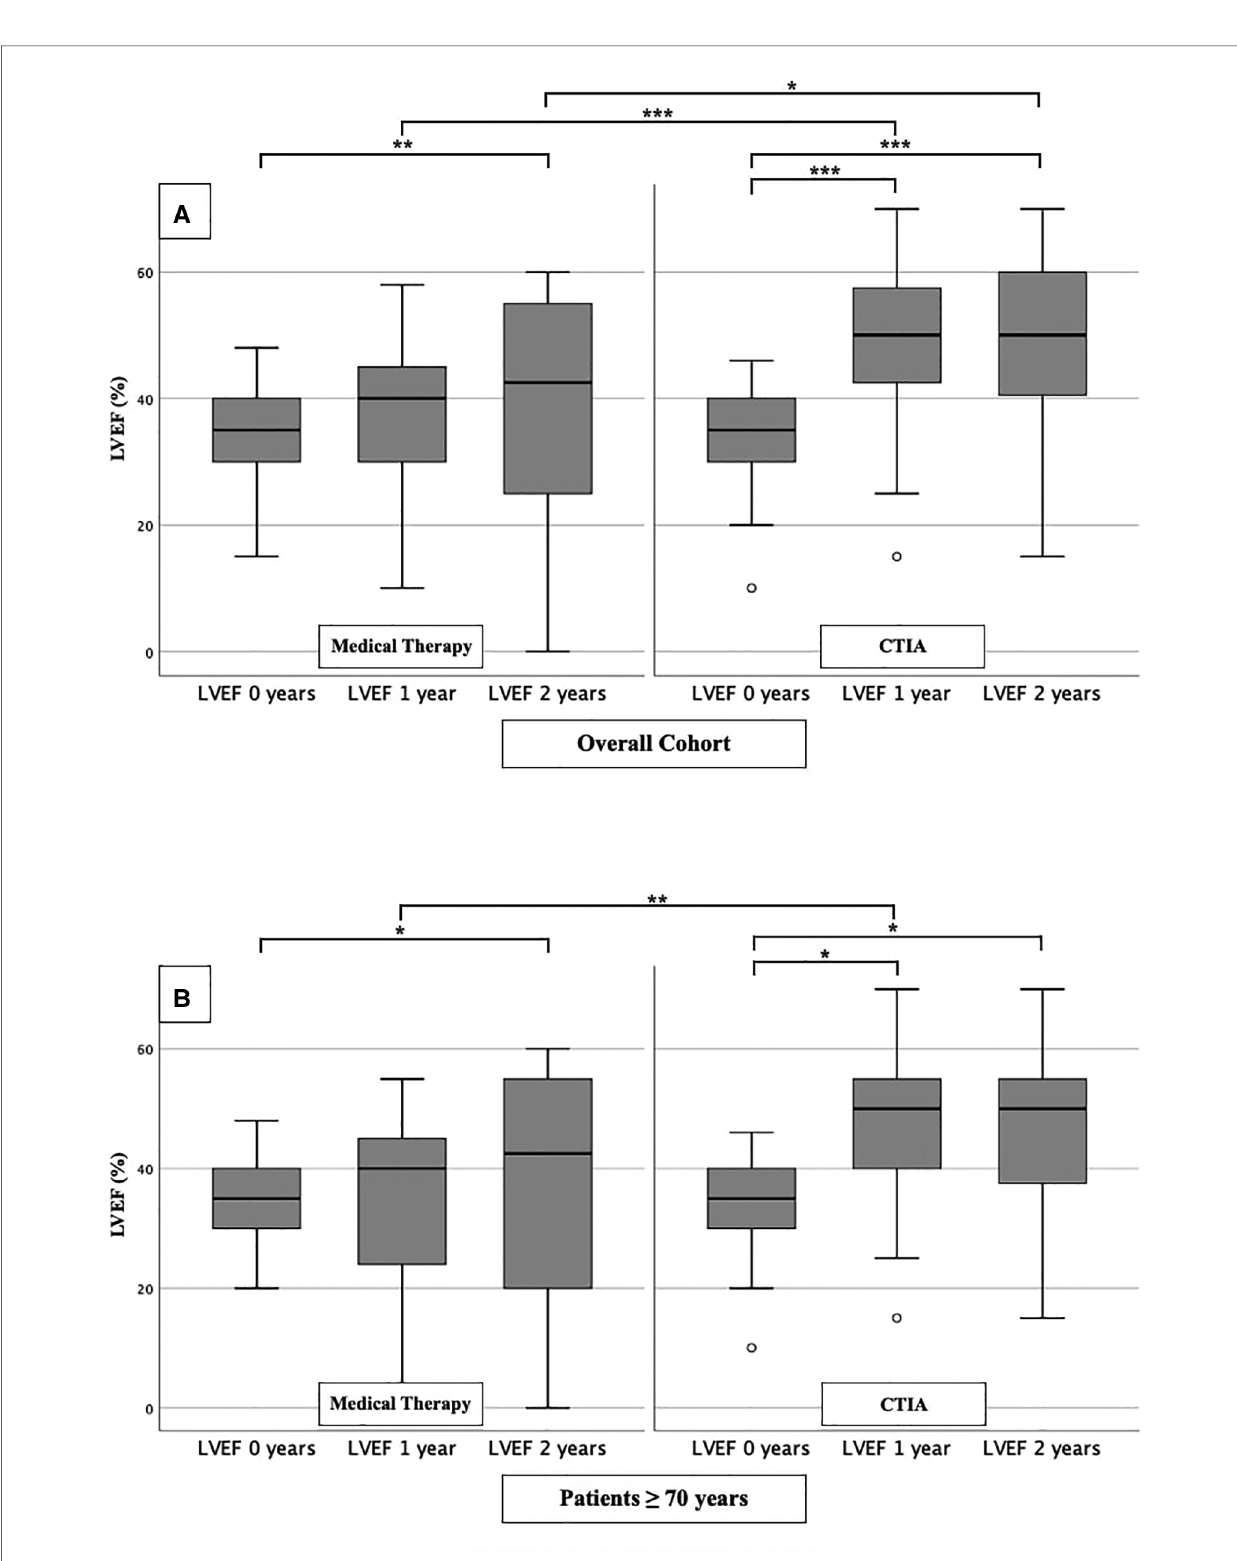
FIGURE 2 LVEF modi fi cations in medical therapy group vs. ablation group of overall cohort. ( A ): All patients of overall cohort with unselected heart failure. ( B ): Patients ≥ 70 years of overall cohort with unselected heart failure. * p ≤ 0.050; ** p ≤ 0.010; *** p ≤ 0.001.